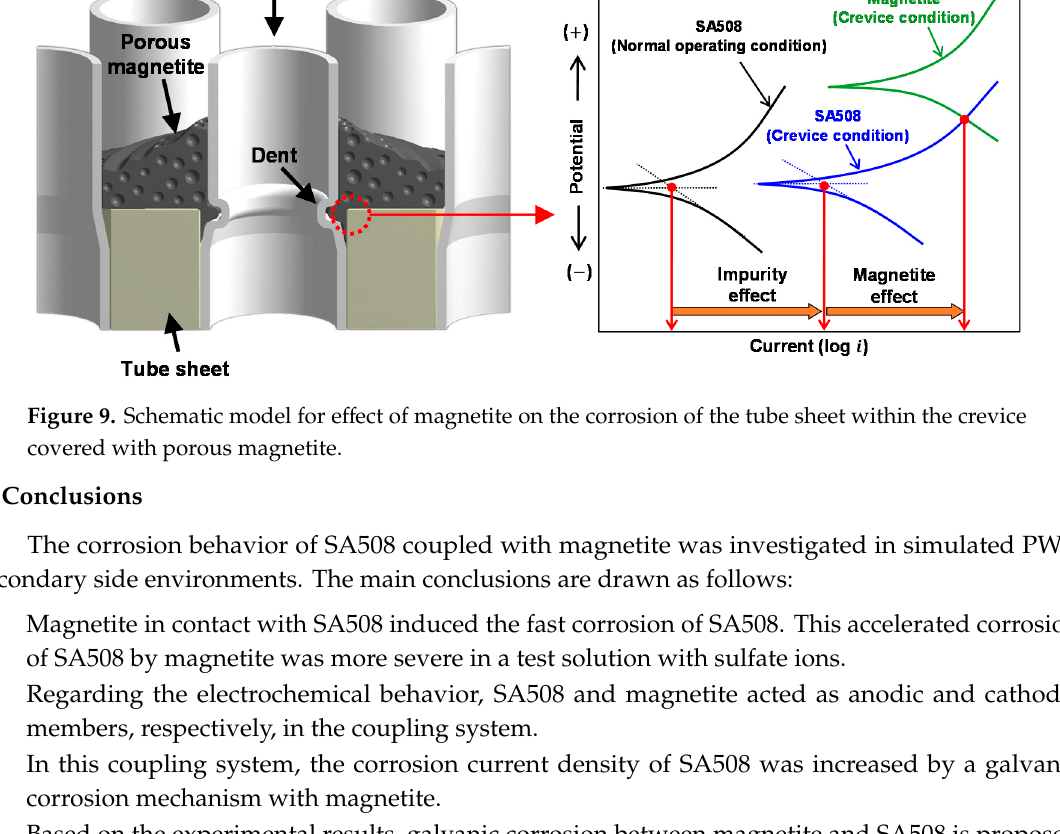
Figure 9. Schematic model for effect of magnetite on the corrosion of the tube sheet within the crevice covered with porous magnetite.